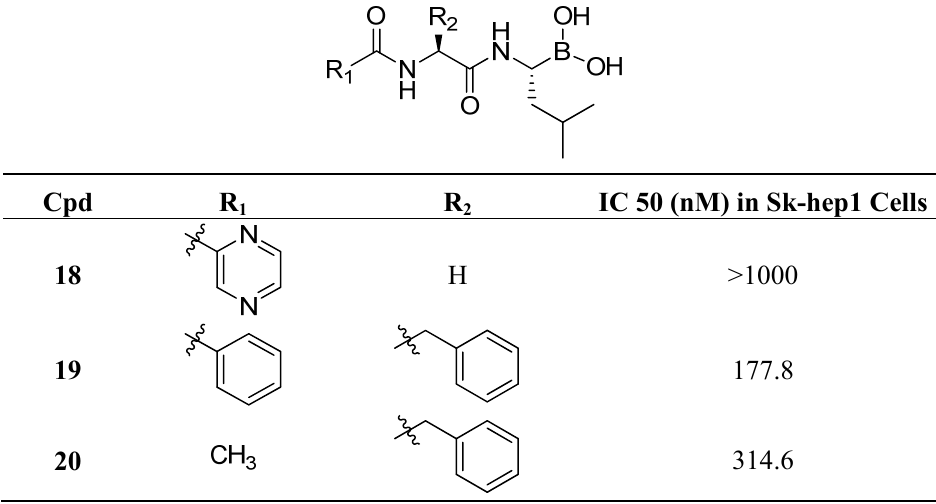
Table 3. Chemical structure of synthetized compounds and IC